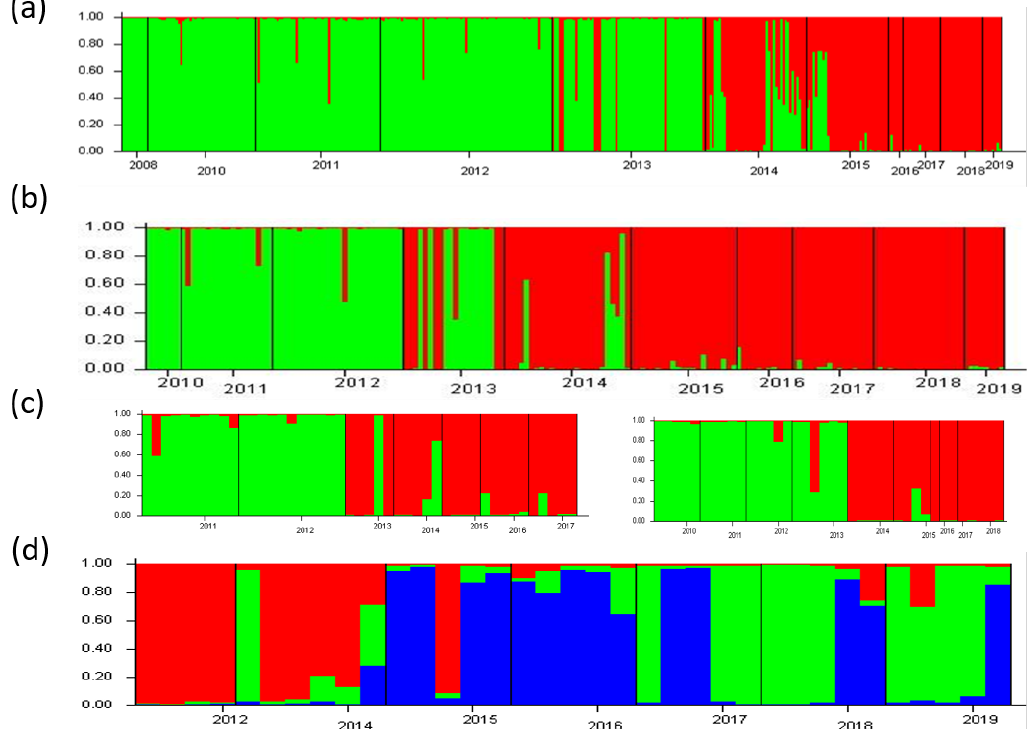
Figure 2. “STRUCTURE” plot that shows the genetic affiliation to groups computed by the program. Each column represents one individual and each color represents one genetic group. Individuals were divided by year of sampling. ( a ) All 374 individuals, K = 2; ( b ) 170 individuals from 6 main breeders, K = 2; ( c ) 45 individuals from breeder 1 and 38 individuals from breeder 3, K = 2; ( d ) 35 individuals from breeder 6, K = 3.